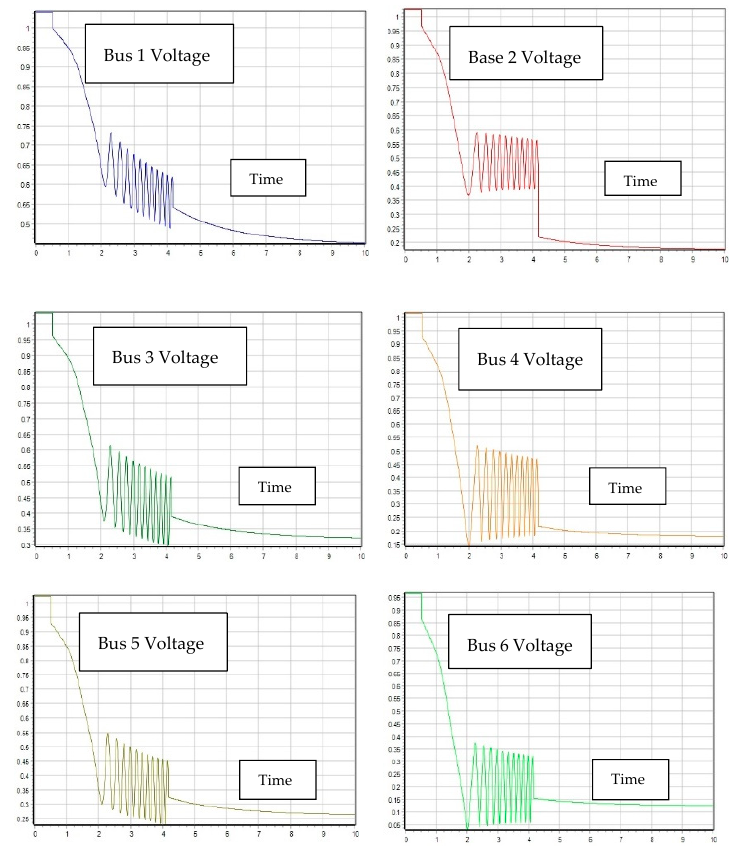
Figure 15. Bus voltages for second transient contingency scenario.